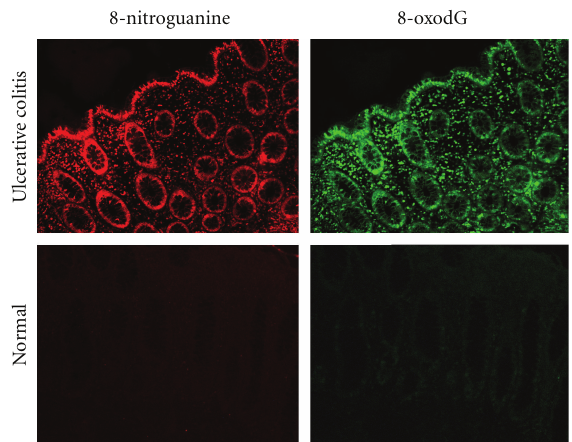
Figure 2: 8-Nitroguanine in colon epithelium of a patient with active ulcerative